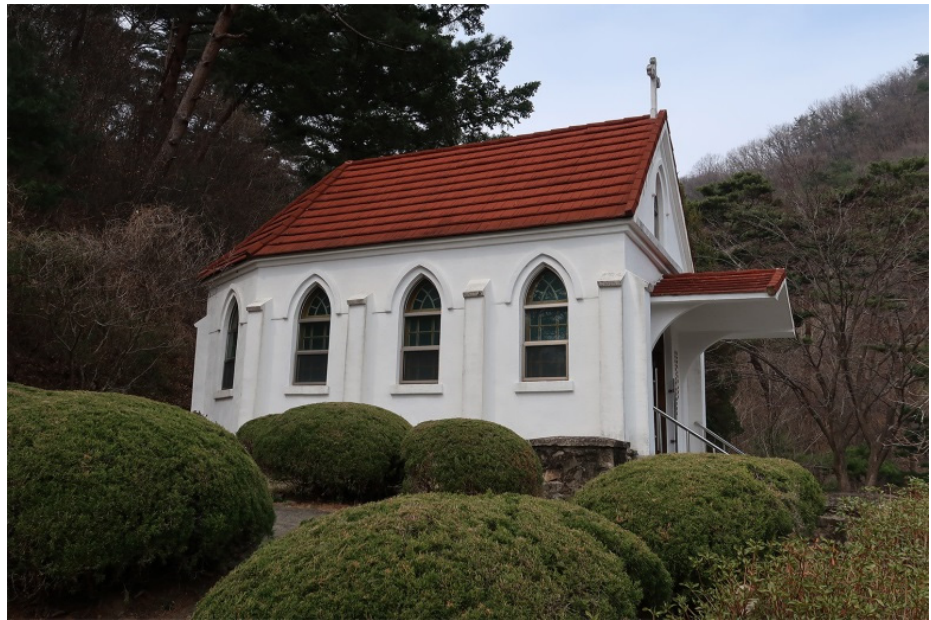
Figure 12. The roof material image of the Memorial Church in 2021 [source: photo by author]. Third, the stone wall around the graves in front of the building was removed. When looking at the initial photos of 1928 and record ( Supplementum Tabella SS. Cordis Jesu ), the approximately two-meter-high wall was built around the graves to mark the boundary (see Figure 13) (Guinand 1928). In a photo in 1965, the wall was still visible (see Figure 14). However, the south and west and east walls around the graves have disappeared and only the steel structure marking the boundary remains.